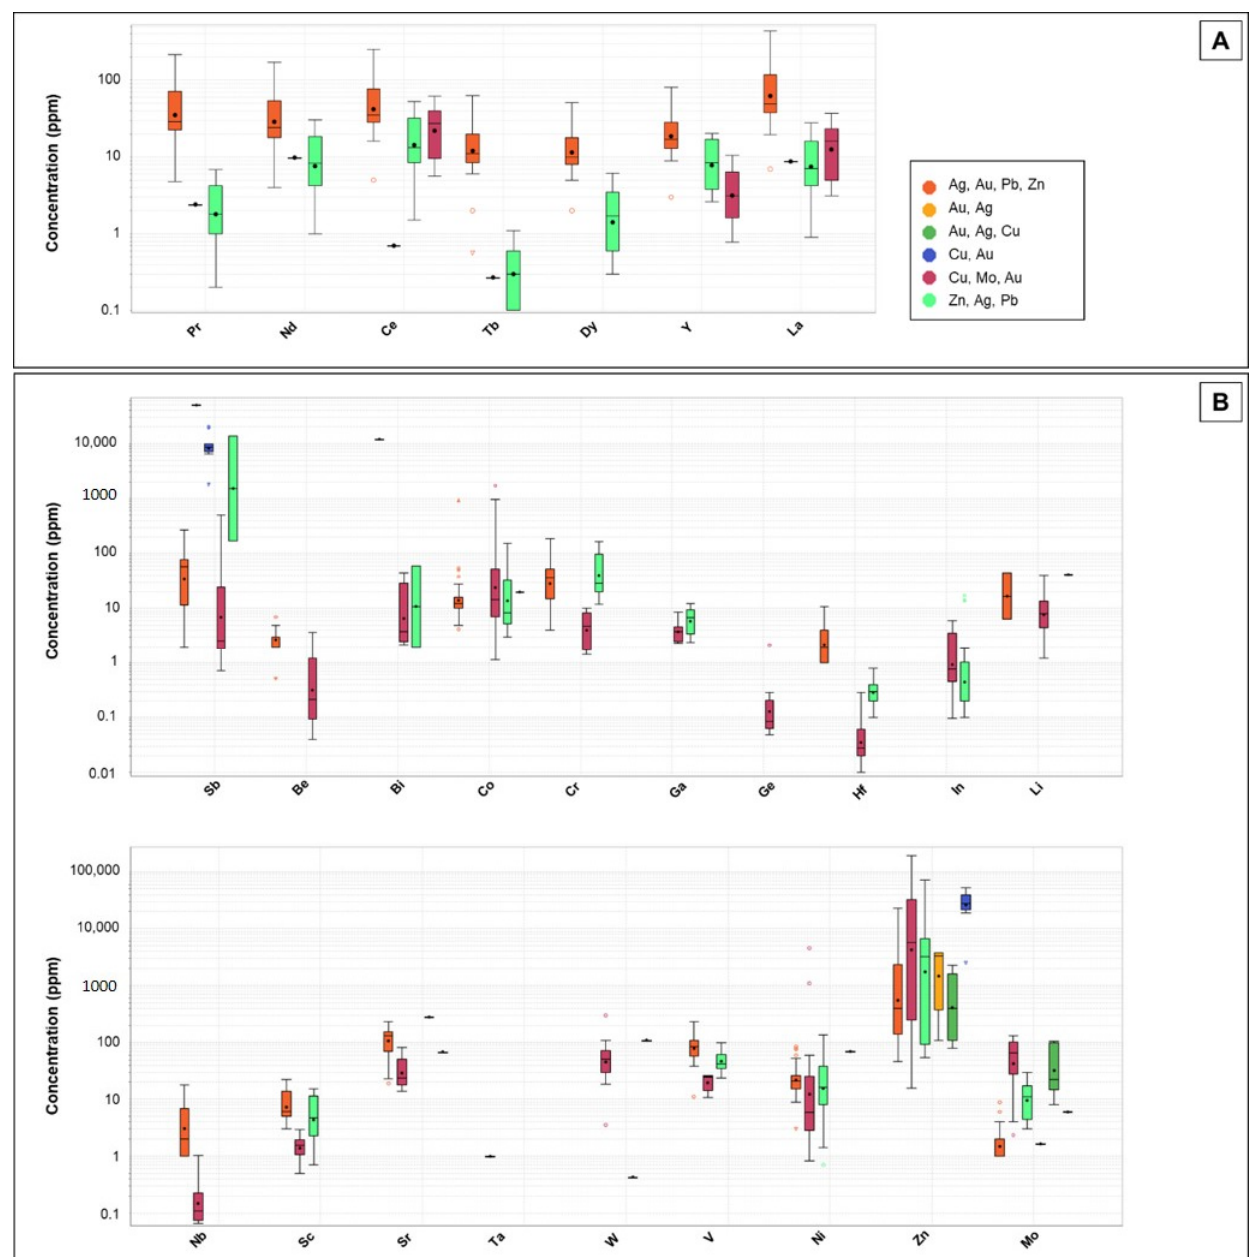
Figure 3. Tukey log-plot graph showing the concentration of the critical elements at each site included in Australia split in ( A ) REEs-Praseodymium, Neodymium, Cerium, Terbium, Dysprosium and Yttrium ( B ) other critical elements. The box is the middle 50% of data from Q1 to Q3. The outliers (circles) are in the top or bottom 5% of the data. The whiskers are the 5% and 95% values.